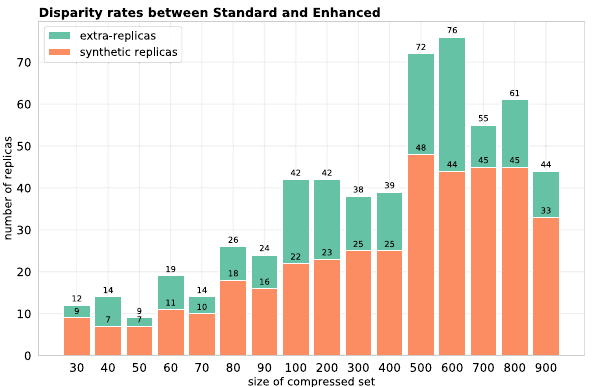
Fig. 7 Thehistogramsrepresentthenumberofdisjointreplicasthatare present in the standard compressed set but not in the GAN-enhanced for the NNPDF4.0 candidate. The results are shown as a function of the size of the compressed set. The numbers of synthetic replicas are